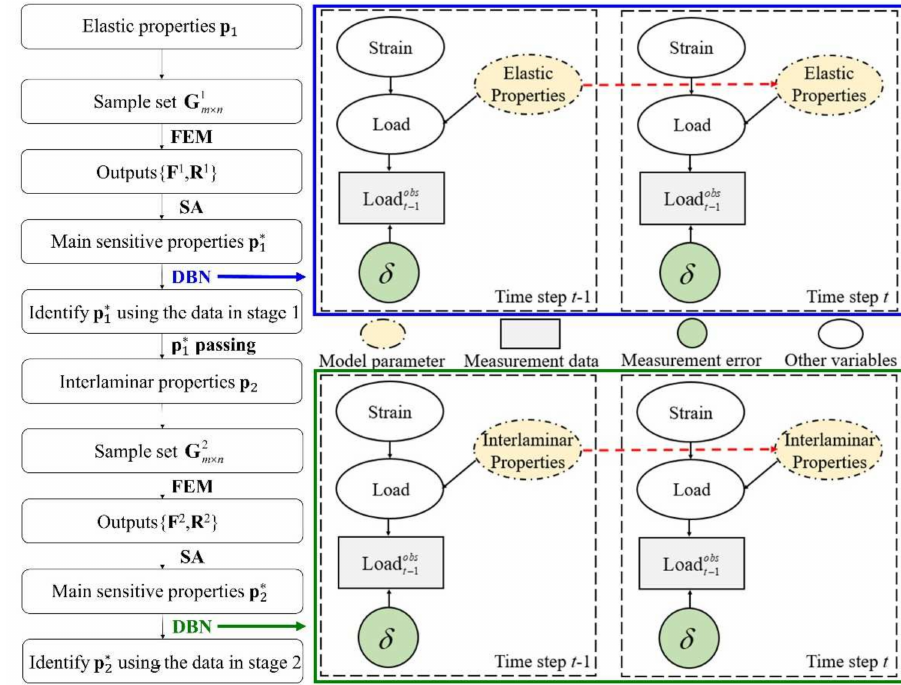
Figure 7. The framework of property identification